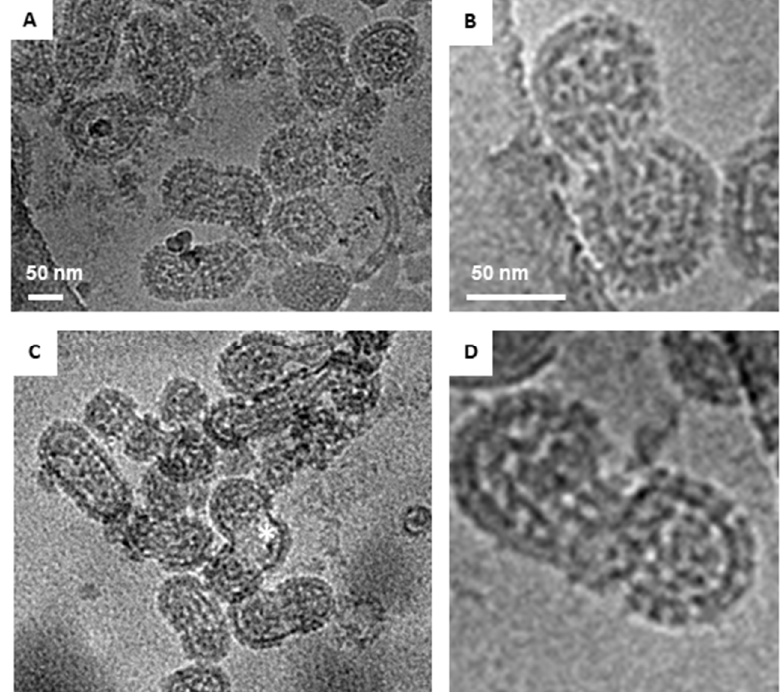
Figure 6. Morphology of two strains of Sin Nombre virus via cryo-EM images. ( A ) Representative image of particles of CC107 displaying round and tubular morphologies. ( B ) Zoomed in view of a particle of CC107 strain with the red boundary indicating spikes on the virus particle. ( C ) Particles of MCV strain displaying tubular and irregular (*) morphologies ( D ) Zoomed in view of a MCV particle. Scale bar = 50 nm.